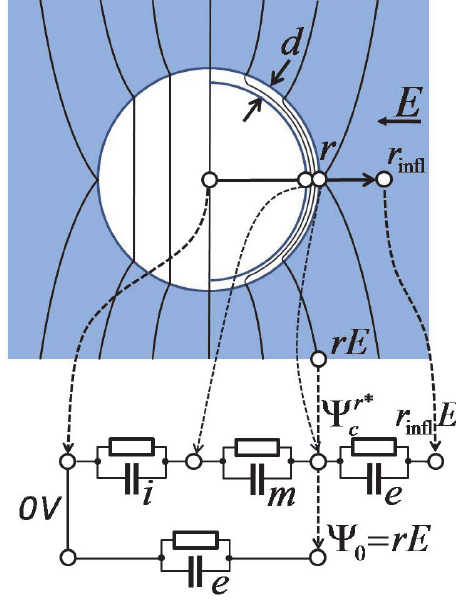
Fig. 5: Equipotential plane distribution in and around a spherical single-shell model of radius r . The external distributions are identical for Maxwell's equivalent body (sketched for the left hemisphere) and the membrane-covered object (sketched for the right hemisphere). Important points in the model are marked by circles. The potentials at these points can be obtained from the RC-model at the bottom, which permits calculation of the induced dipole moment and transmembrane potential. From the existence of Maxwell's equivalent body, it follows that electric measurements (detecting the induced dipole moment) do not allow one to distinguish whether frequency-dependent object properties stem from internal structures or from the frequency- dependent properties of the media of which the object is